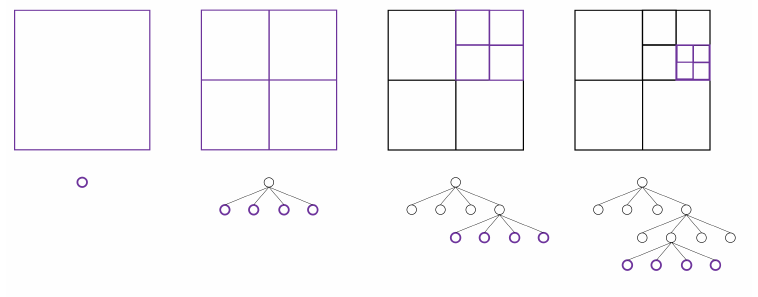
Figure 5. The refinement procedure of a two-dimensional tree-based AMR grid and the corresponding quadtree structure. The purple lines and circles represent leaf